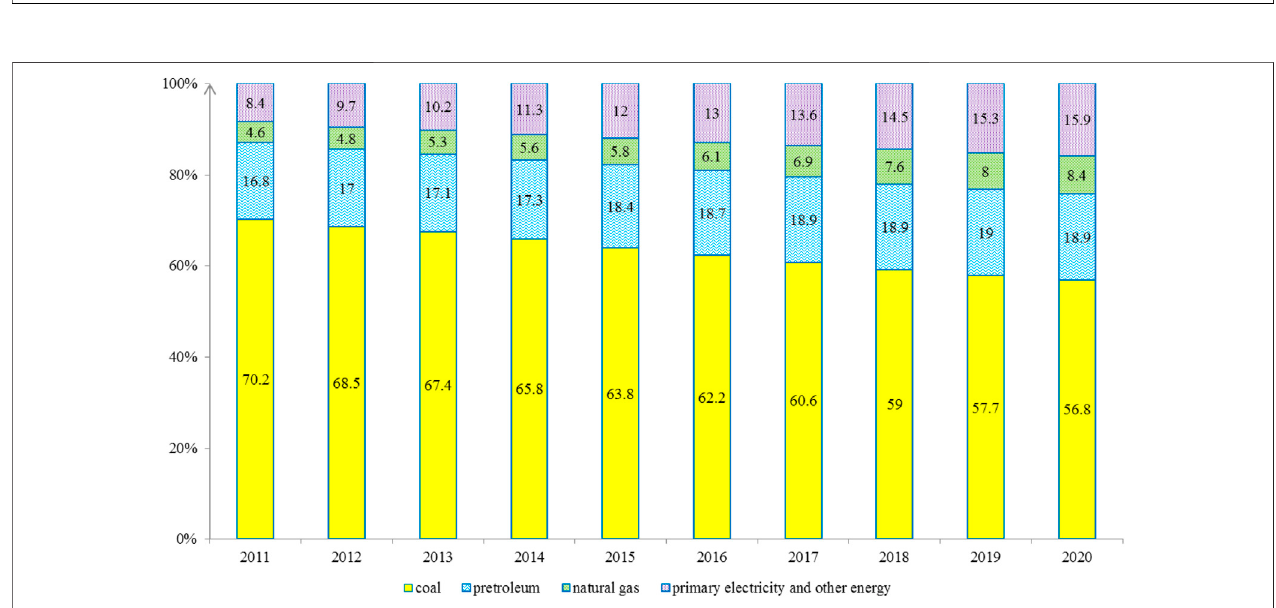
FIGURE4| CompositionofenergyconsumptioninChinaduring2011 – 2020(%).Source:Theauthorsearchedtheinformationfrom TotalEnergyconsumptionand Its Composition in the China Statistical Yearbook 2021.